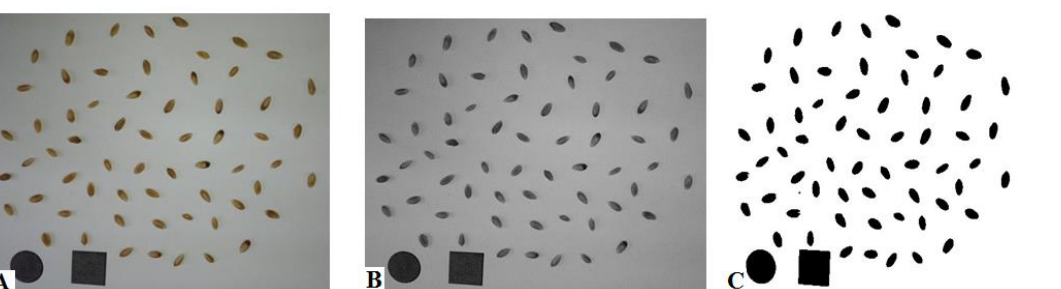
Fig. 2. Steps of digital wheat grain image analysis in MATLAB software: A) Image of grains in colored space RGB; B) Gray image of grains; C) Binary image of